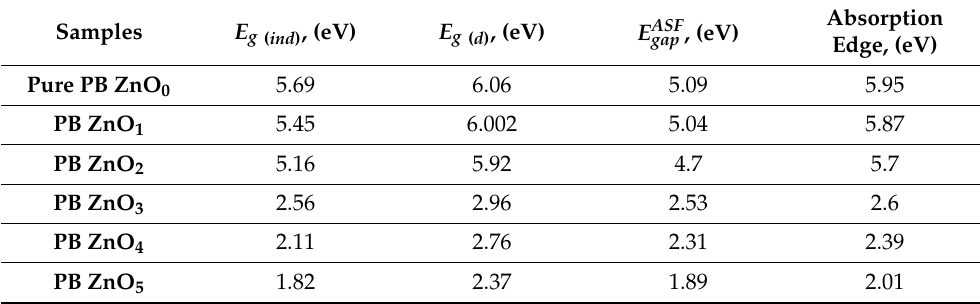
Table 2. Optical indirect/direct Bandgap of ZnO NPs-doped PVA/PVP polymeric nanocomposites.